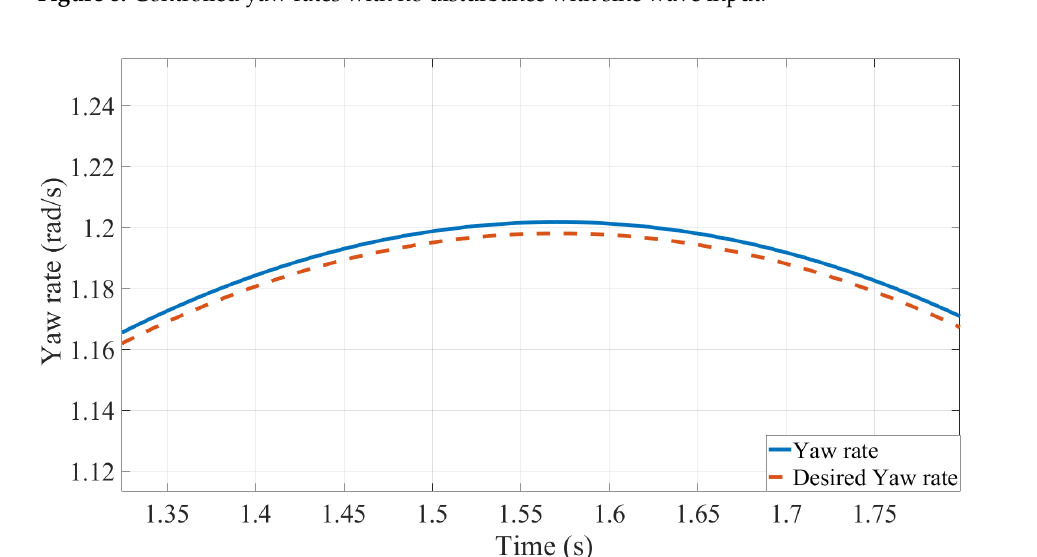
Figure 9. Controlled yaw rates with no disturbance with sine wave input, zoomed